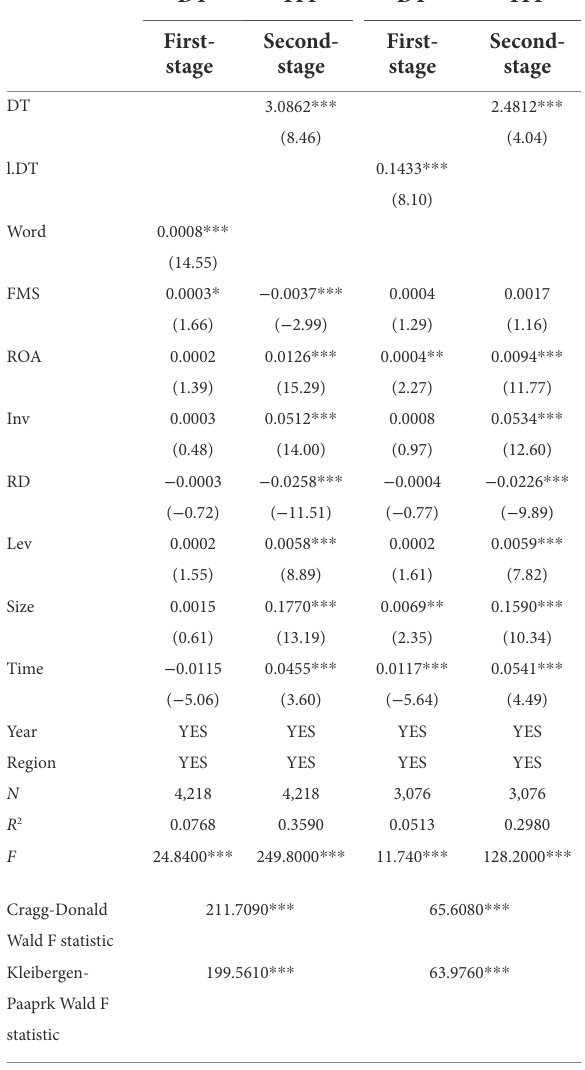
TABLE 4 Instrumental variables method results.